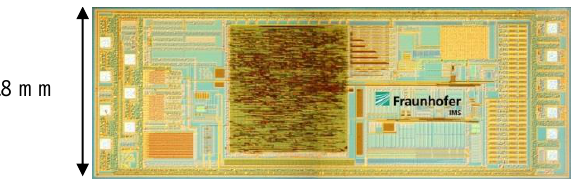
Figure 7. Photograph of the SPP-chip.